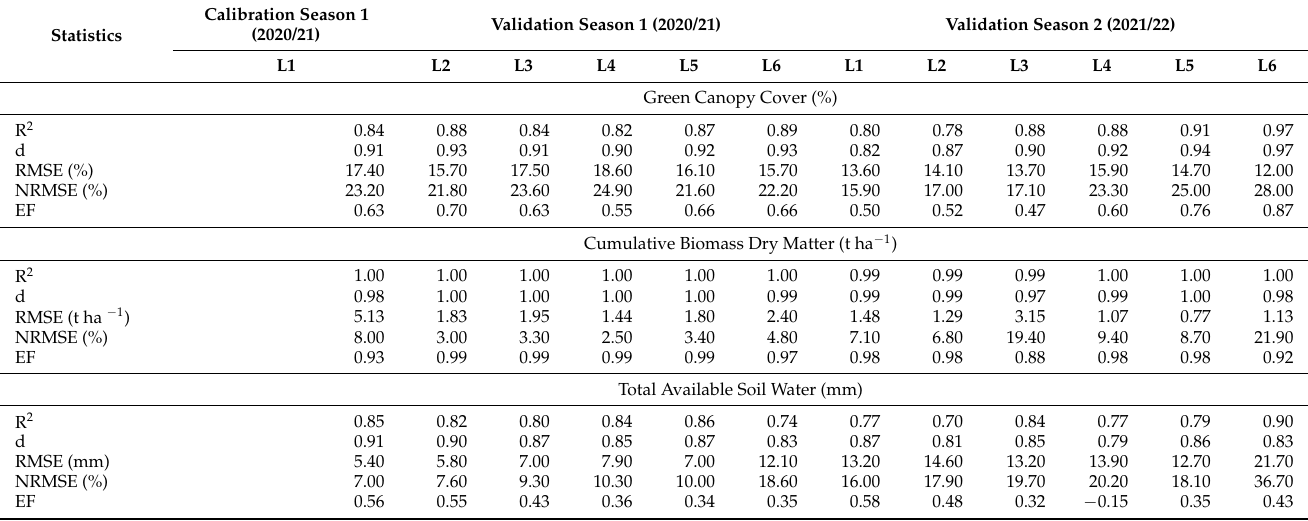
Table 6. Statistical indicators of green canopy cover, cumulative biomass, and total available soil water simulated by AquaCrop (calibration and validation) under different treatments in two growing seasons (2020/21 and 2021/22) of Guinea grass ( Megathyrsus maximus cv. Agrosavia sabanera).